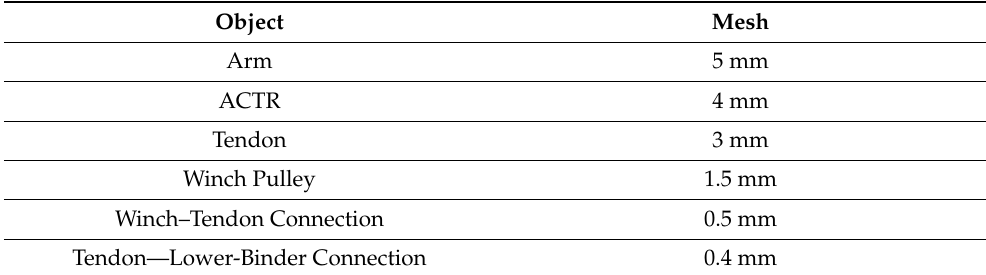
Table 3. Mesh resolution for manipulator components and connection points.